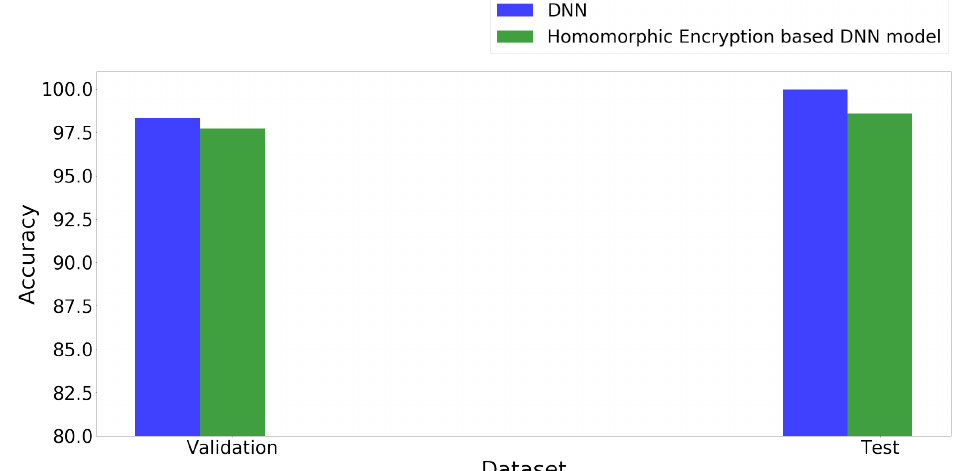
Figure 5. Accuracy-wise performance of the proposed methodology.